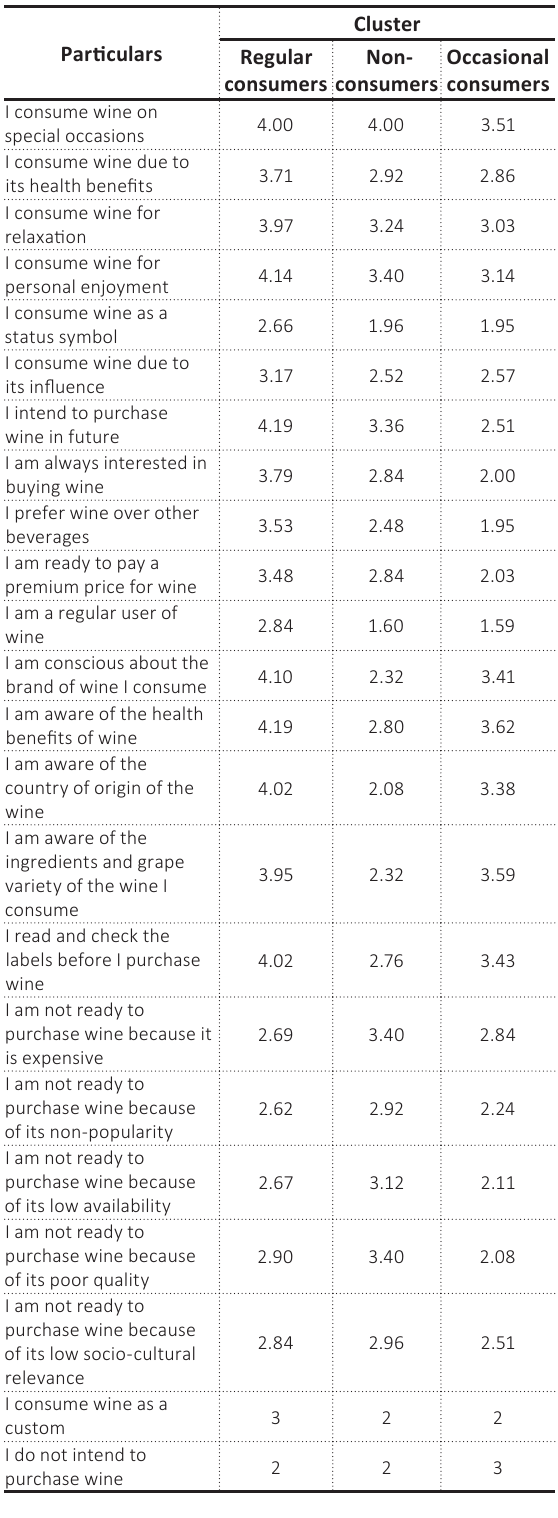
Table 6. Final cluster